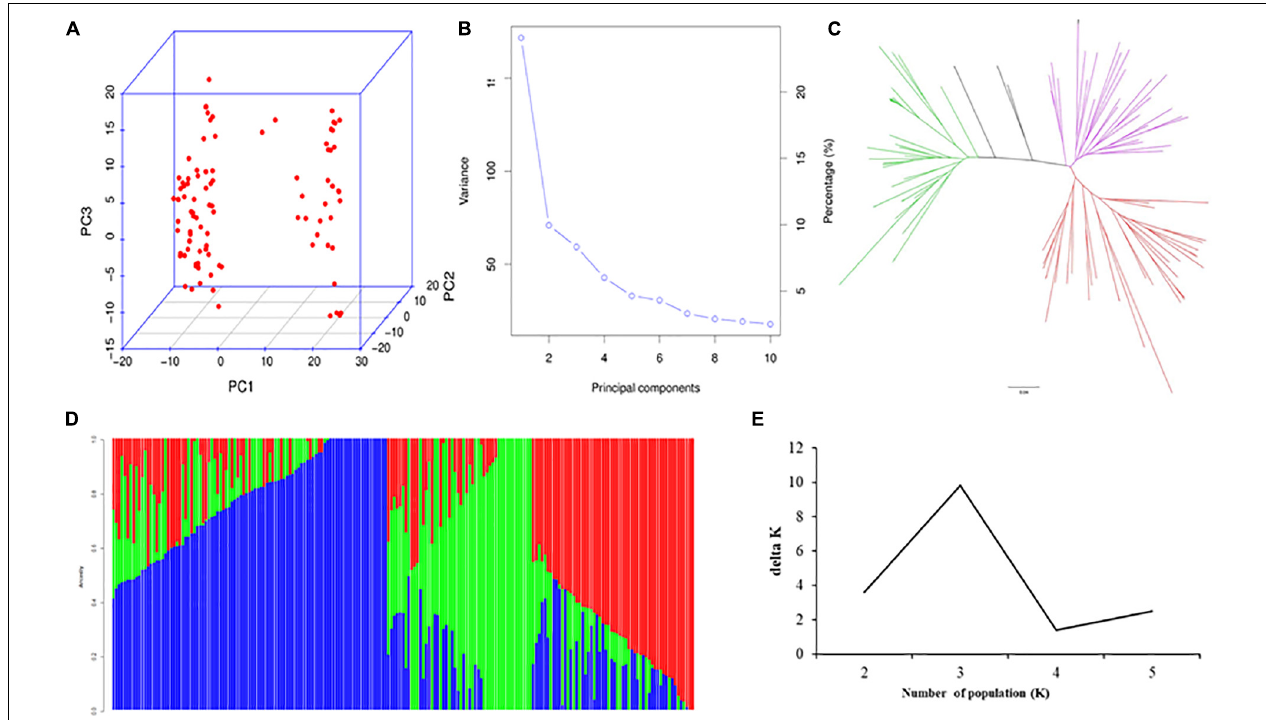
FIGURE 1 | Population analysis for the accessions from the SC panel. (A) PCA plots, (B) total variation explained by PCs, (C) NJ tree, (D) three subgroups inferred by structure analysis, (E) estimated (cid:49) K over five repeats of structure analysis.